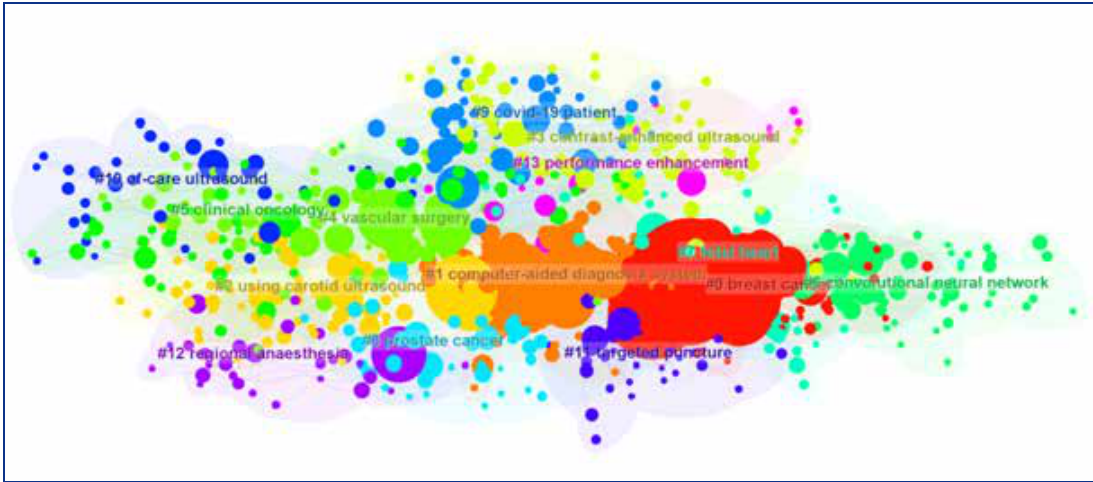
Figure 2 Keyword cluster analysis results of papers on the application of AI in ultrasound in the last decade. Different colors represent different classes, and the number label represents the size of the class. The smaller the number, the larger the corresponding class, and the higher the frequency of the keyword in papers we reviewed. In the figure, the three largest categories are: “#0 breast cancer”, “#1 computer-aided diagnosis system”, “#2 using carotid